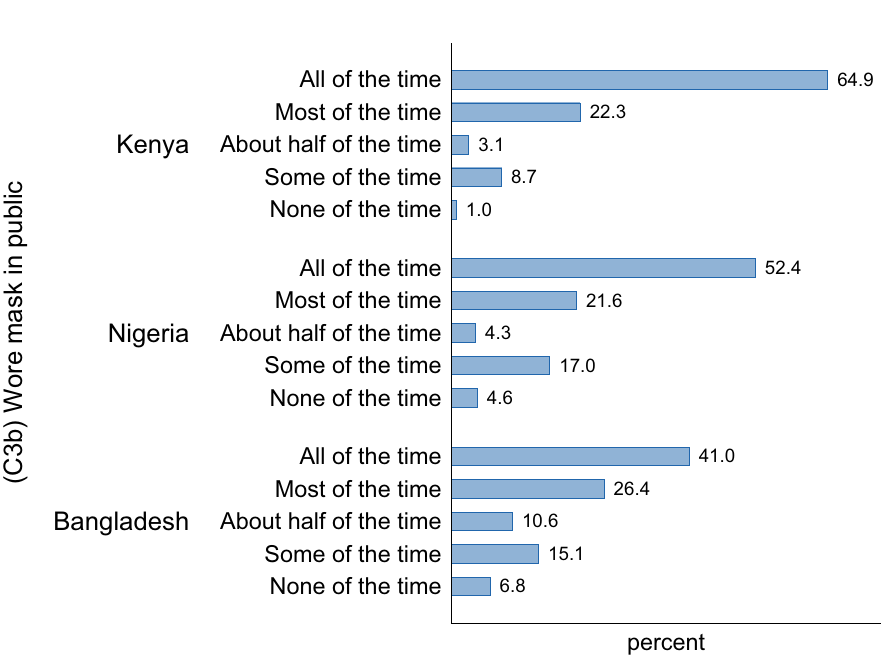
Fig 1. Self-reported mask-wearing in public, by country. Notes: Findings from phones surveys carried out in Kenya (N = 1647), Nigeria (N = 1608), and Bangladesh (N = 1722). The respondents were asked “In the last 7 days, how often did you wear a mask when out in public?”. The tabulations reflect country specific weights.